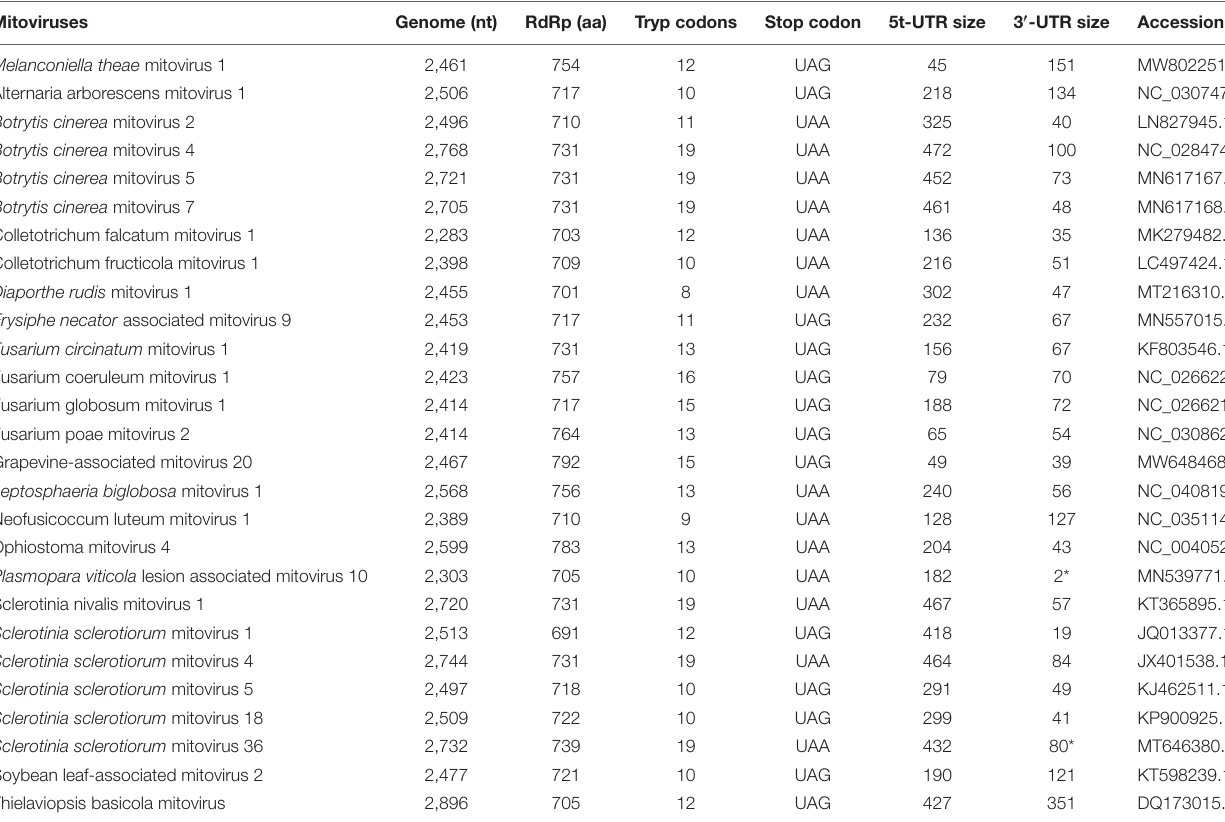
TABLE 1 | Comparison of genomic information of MtMV1 and other